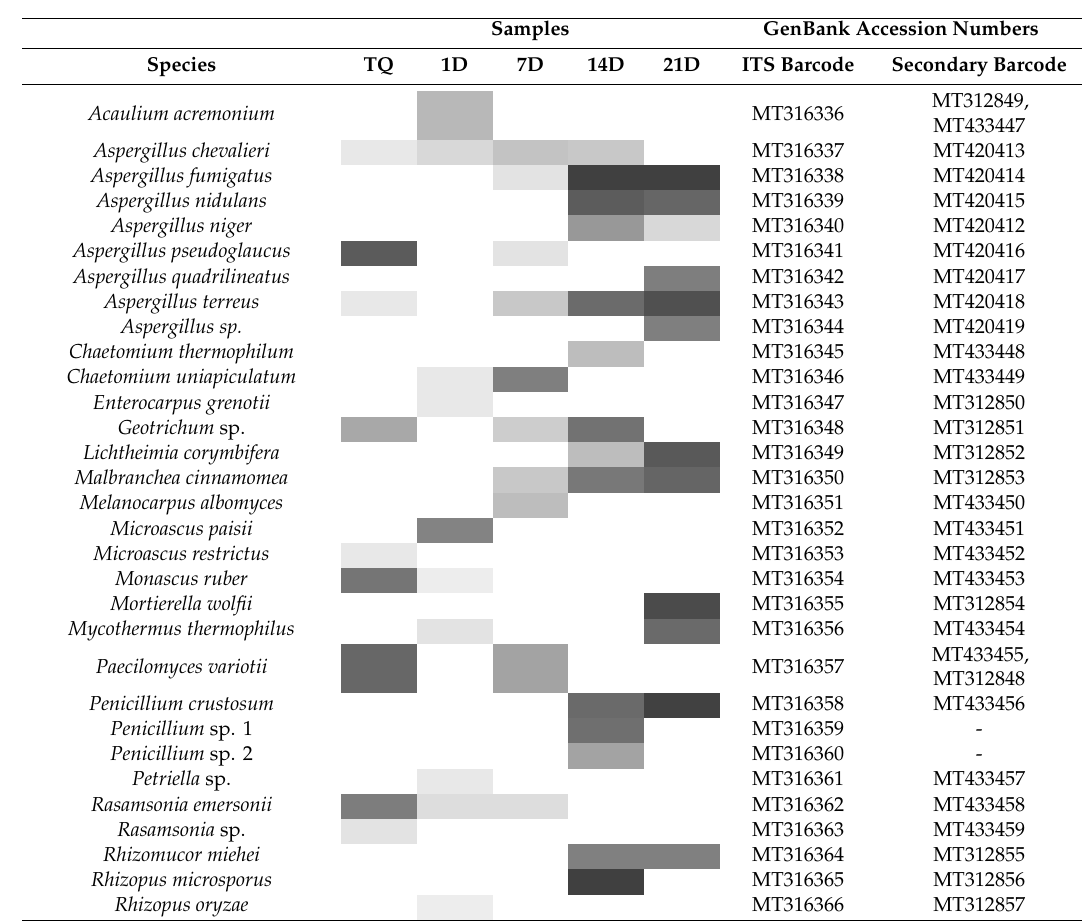
Table 2. Heat map showing isolated species and their abundance (calculated as CFU g − 1 of compost), at each observed time. Their related GenBank accession numbers are reported; - means that the secondary barcode is not